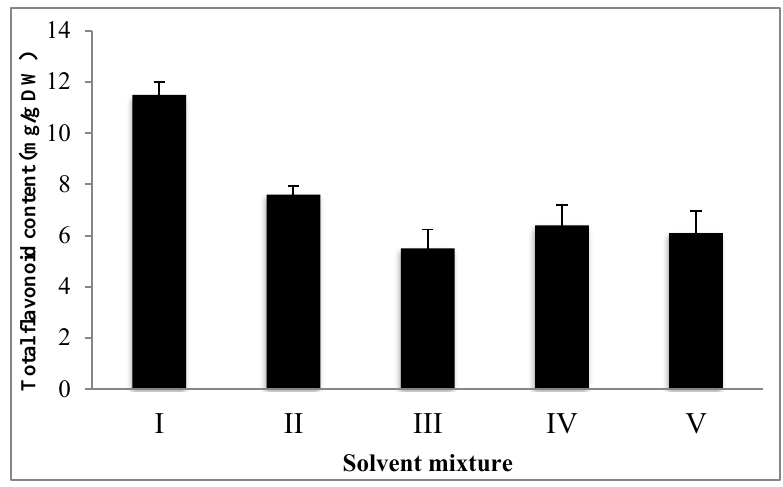
Figure 1. Type of solvent mixture used for extraction.